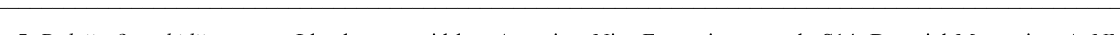
Fig. 5. Dalejina ? rashidii sp. nov.; Llandovery, mid-late Aeronian, Niur Formation, sample S14, Derenjal Mountains. A , NMW 2011.11G.194(cid:150)196, two dorsal valves and one ventral valve on the bedding surface; B , NMW 2011.11G.204, ventral valve exterior; C , D , G , L , M , NMW 2011.11G.205, holotype, dorsal valve, enlarged view of cardinalia, interior, exterior, side and posterior views; E , NMW 2011.11G.201, ventral valve interior; F , I , NMW 2011.11G.203, ventral valve exterior, side view; H , NMW 2011.11G.200, ventral valve interior; J , K , N , O , NMW 2011.11G.206, dorsal valve, posterior and lateral views, interior, exterior; P , NMW 2011.11G.202, incomplete dorsal valve interior. All scale bars 2